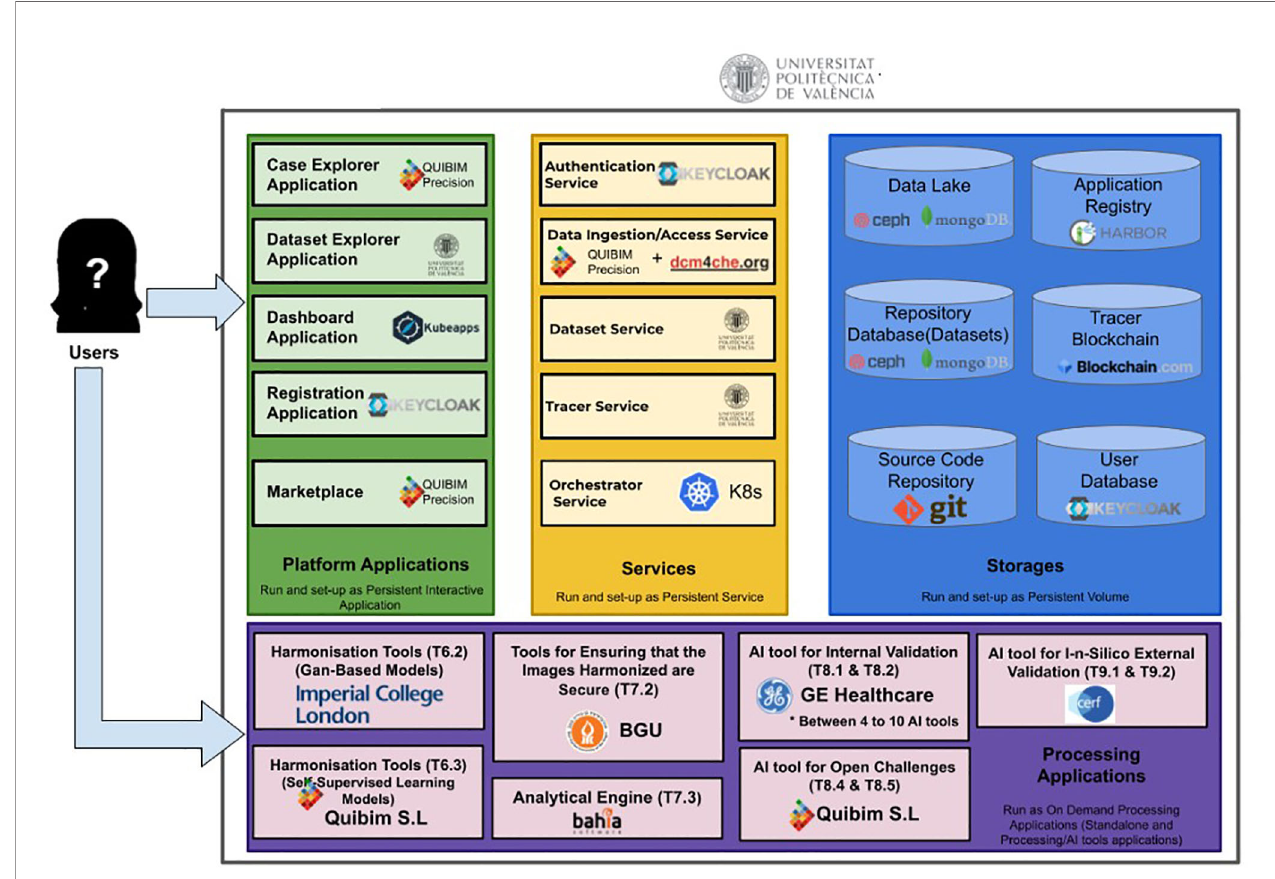
FIGURE 3 | High-level architecture of the central repository and technologies